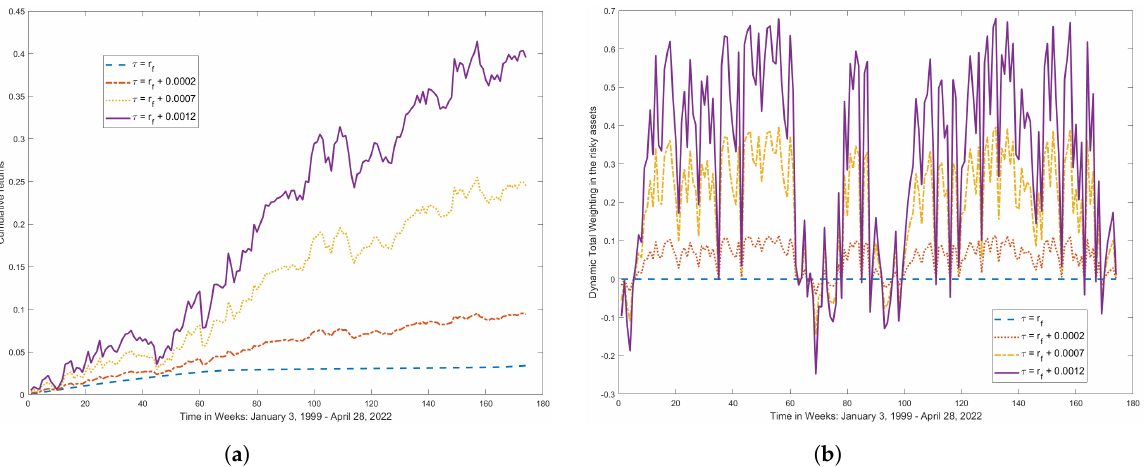
Figure 2. Cumulative Portfolio Returns and Net Investment by Target Return. ( a ) Portfolio returns by target return; ( b ) Net investment in the risky asset.